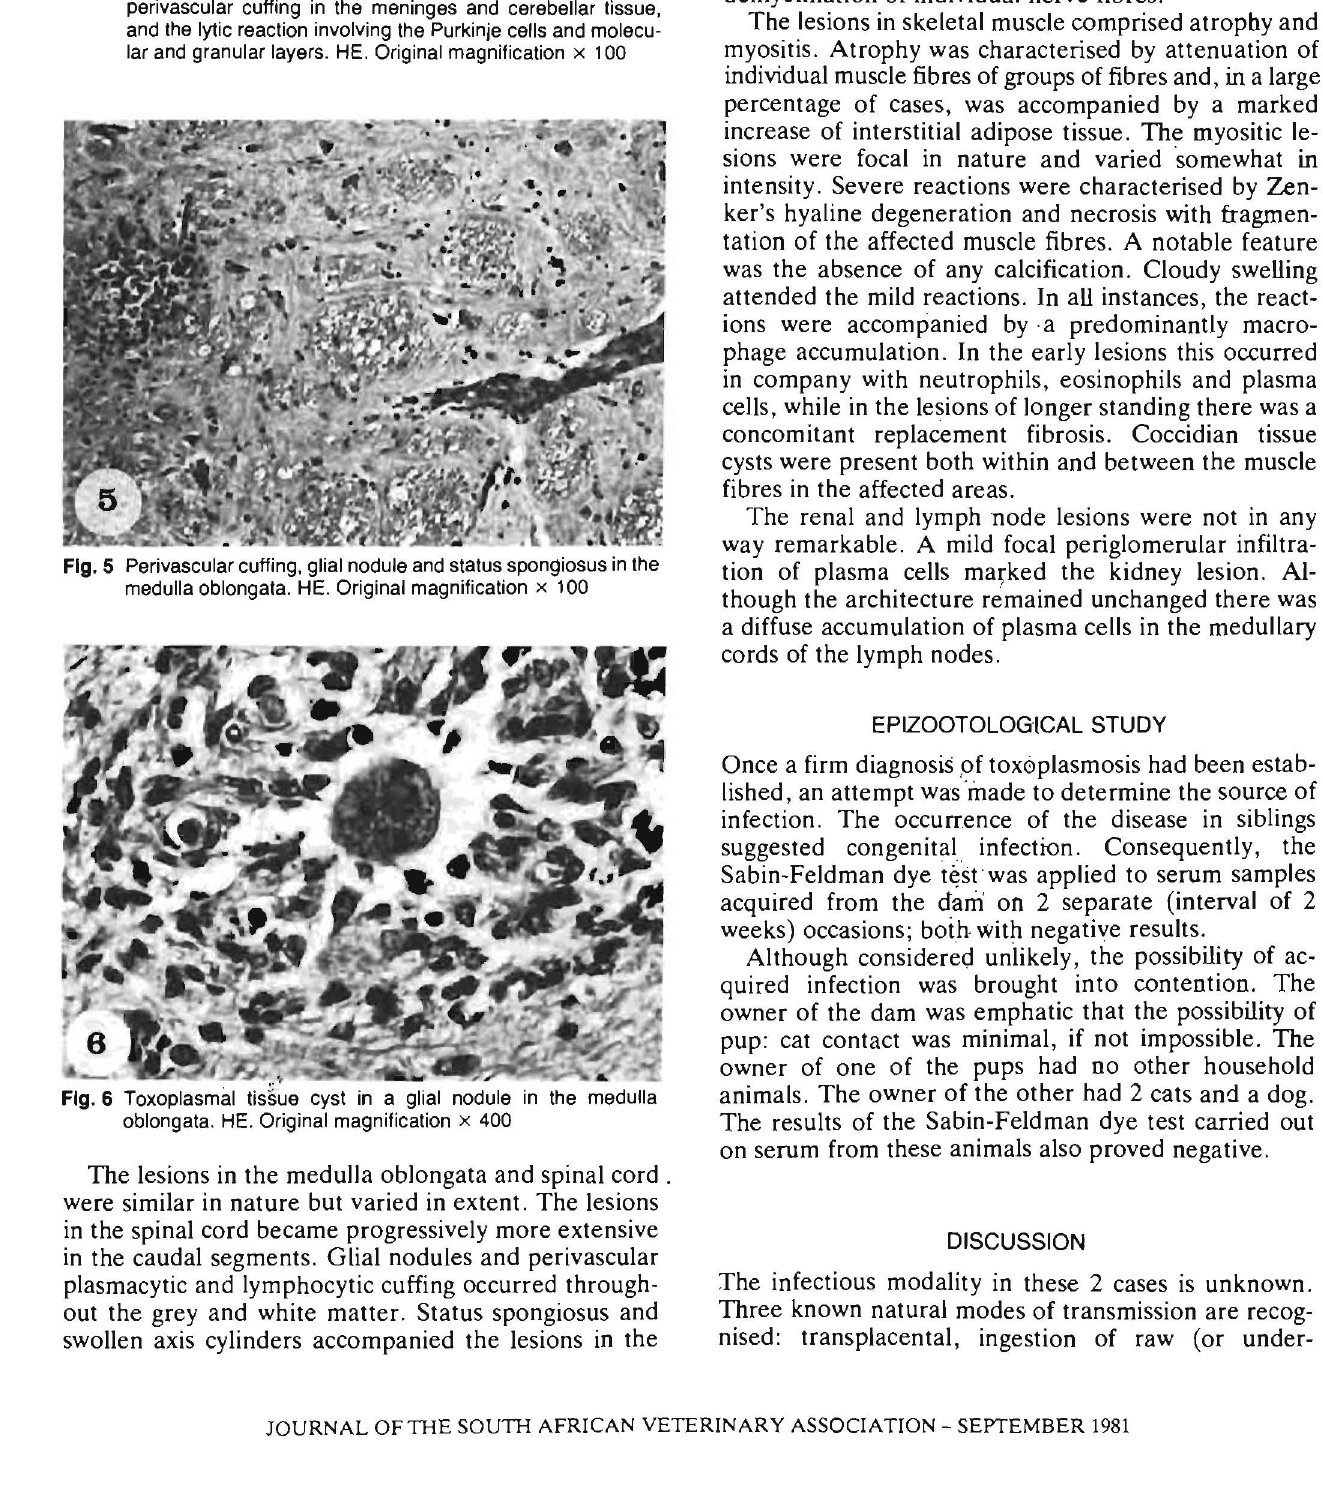
Fig. 4 Meningo-encephalitis of the cerebellum. A toxoplasmal tissue cyst (arrowed) is present in the molecular layer. Note the perivascular cuffing in the meninges and cerebellar tissue, and the lytic reaction involving the Purkinje cells and molecu lar and granular layers. HE. Original magnification x 100